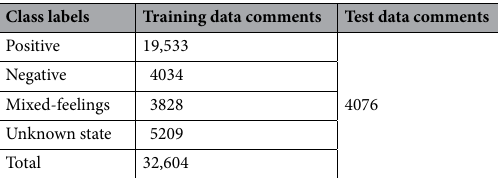
Table 2. Sentiment analysis class labels details.